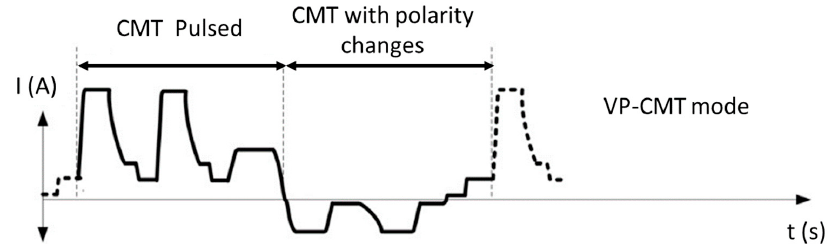
Figure 15. Current wave form of variable polarity cold metal transfer mode (adapted from [81]).